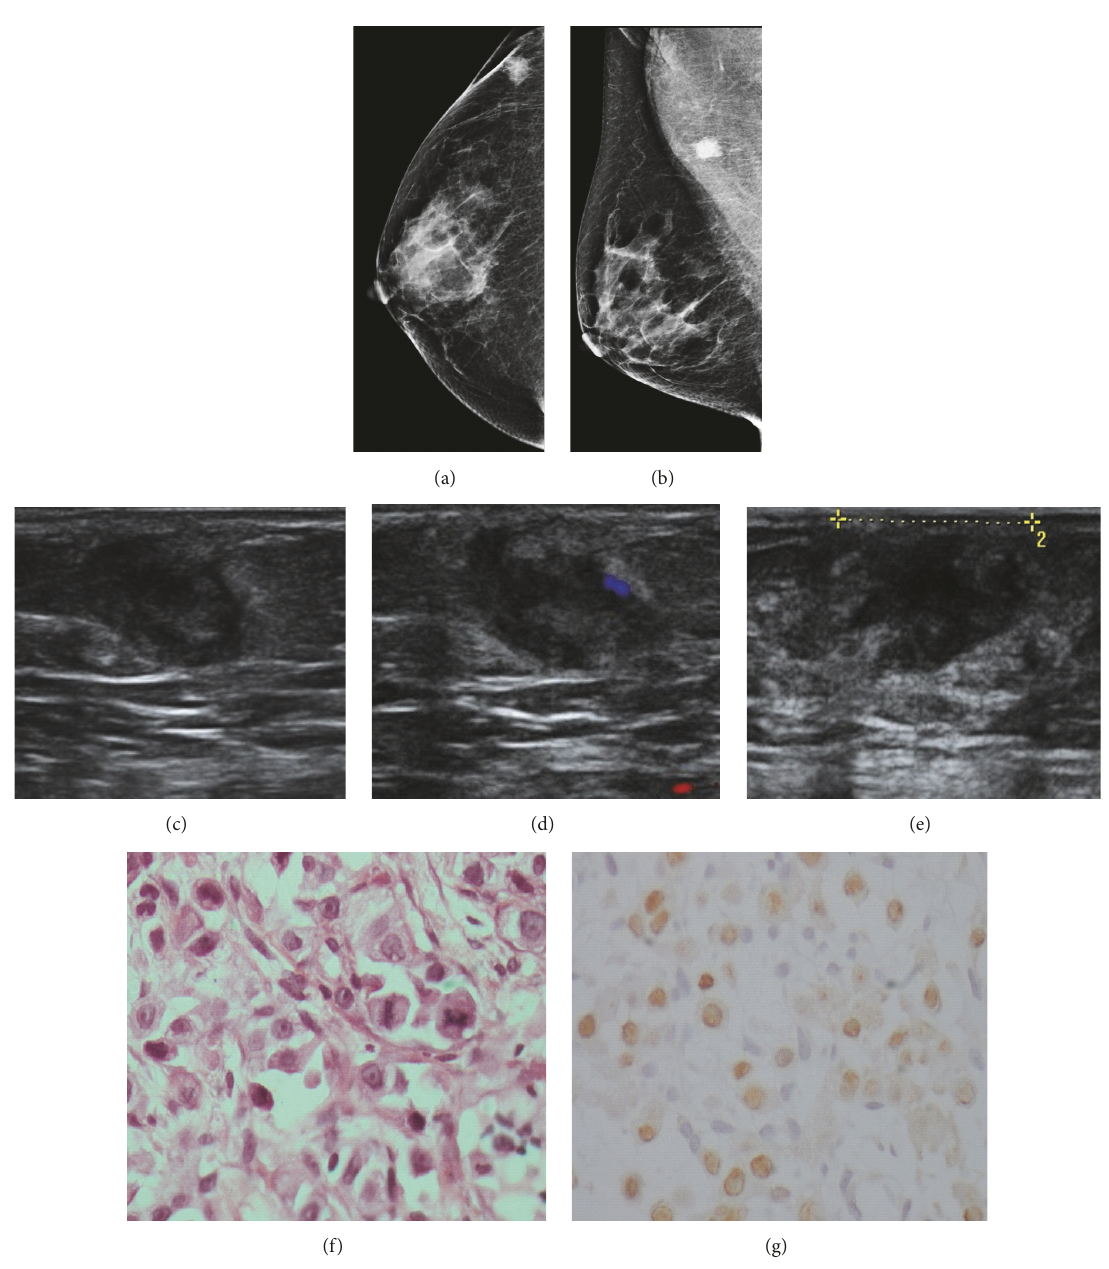
Figure 12: Case 12. 42-year-old woman with carcinoma of the tongue. One year after diagnosis, the patient presented with a palpable mass in the right breast. On mammography, an irregular, isodense mass was noted in the breast tail ( a–b ). An oval mass with circumscribed margins and a heterogeneous echo pattern was seen on ultrasound. The lesion also showed posterior acoustic enhancement( c–e ), while color Doppler images demonstrated peripheral vascularity ( d ). HE staining and immunohistochemistryanalysis of the metastases. HE staining revealed the malignant cells in the breast tumor ( f ), and the immunohistochemistry analysis indicated that the cells were positive for P63 ( g